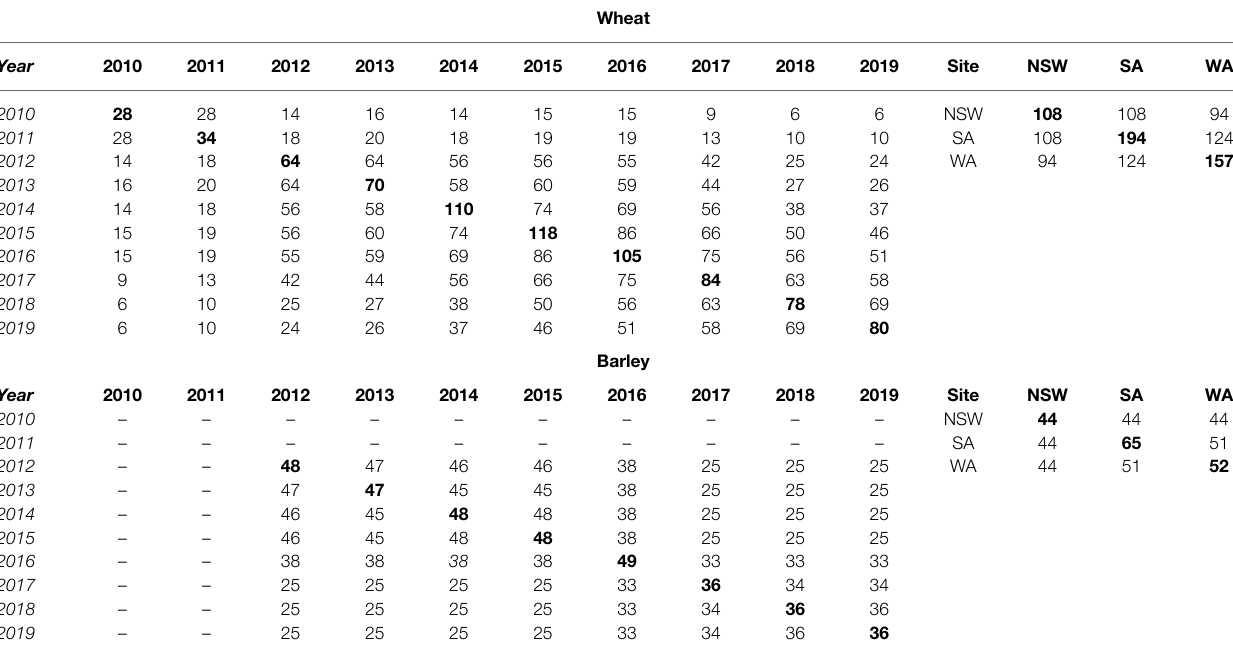
TABLE 2 | Variety connectivity showing the number of varieties in common between each pair of years and states (on the off-diagonal) for the MET data-set, while the numbers highlighted in bold on the diagonals are the total number of varieties used in that year and